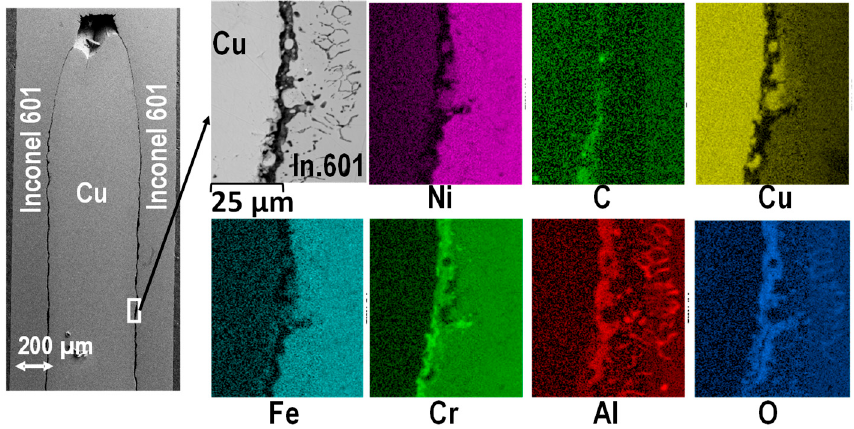
Figure 5. EDS mapping of the interface between copper and Inconel 601 after heat treatment of a sample prepared with oil. Mapping was done in the white rectangle.